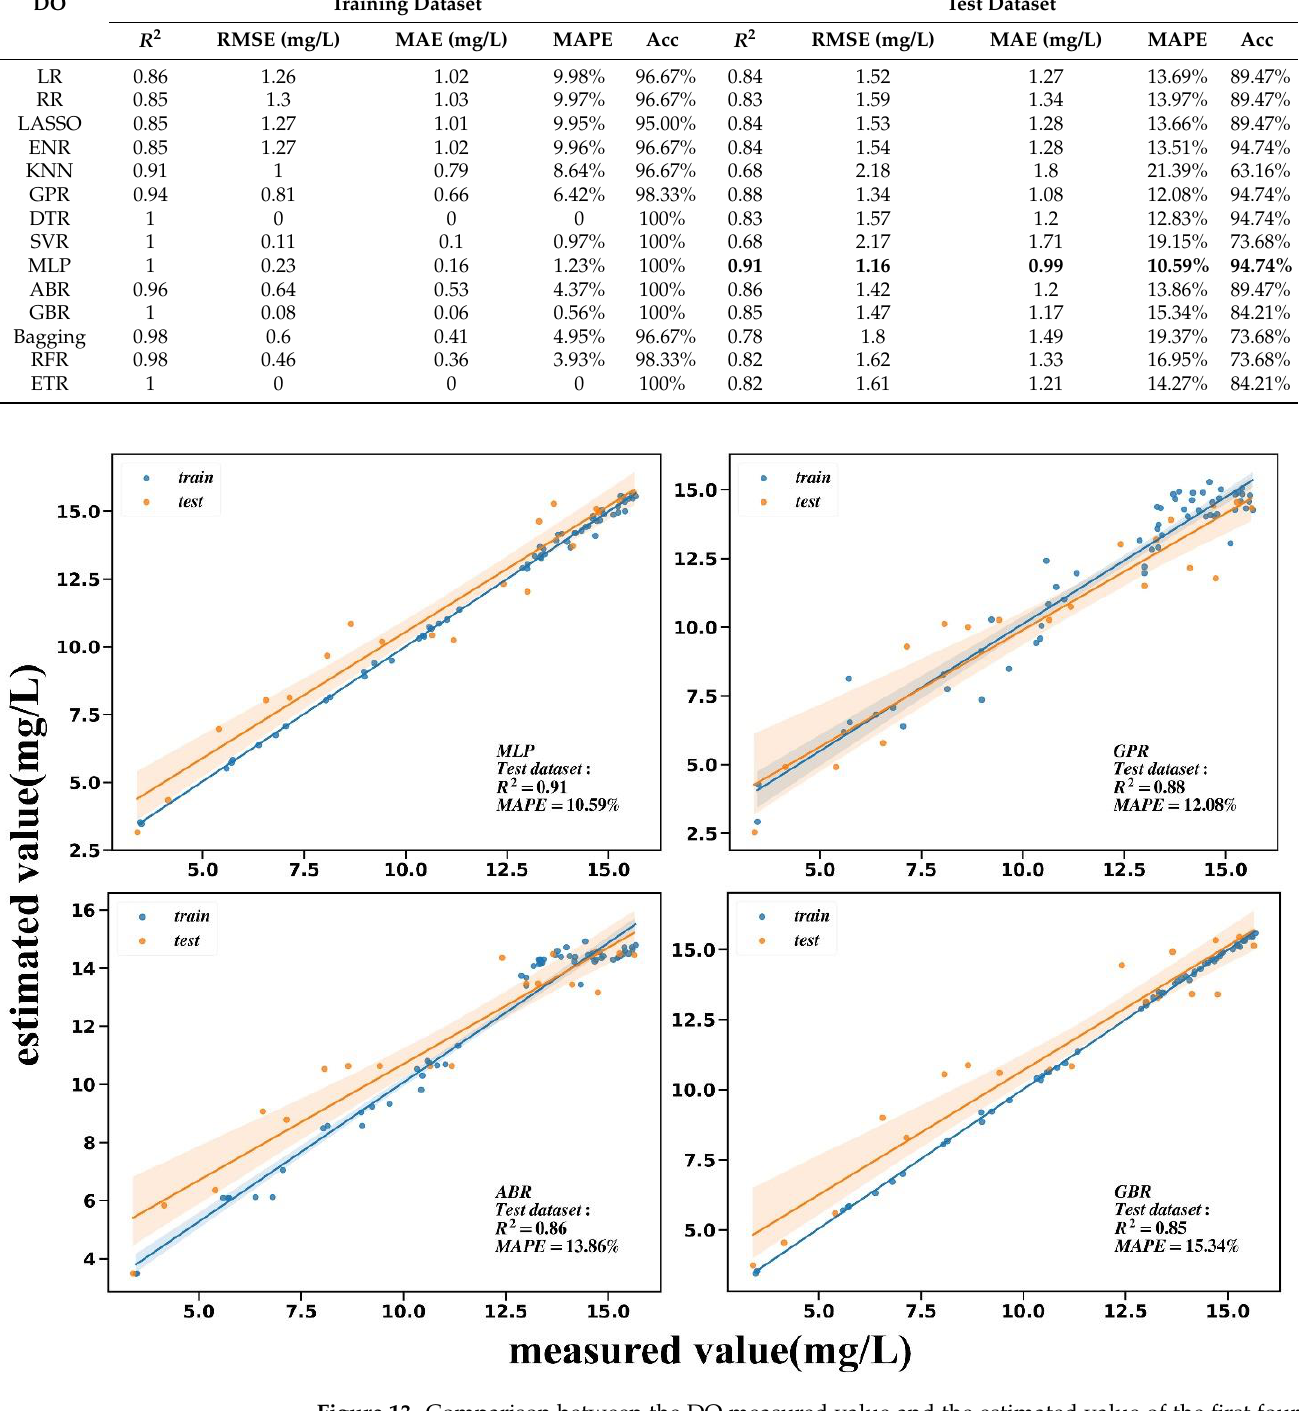
Figure 13. Comparison between the DO measured value and the estimated value of the first four models with the highest 𝑅 2 of the test dataset.